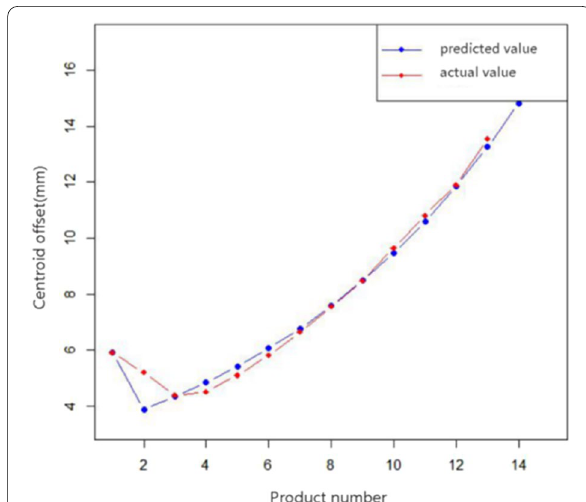
Figure 4 Fitting curve of centroid offset